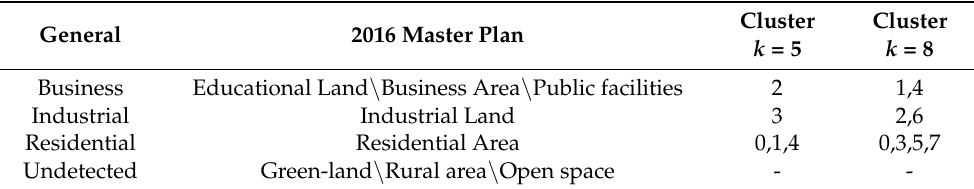
Table 2. The mapping between 2016 Master Plan data and cluster.